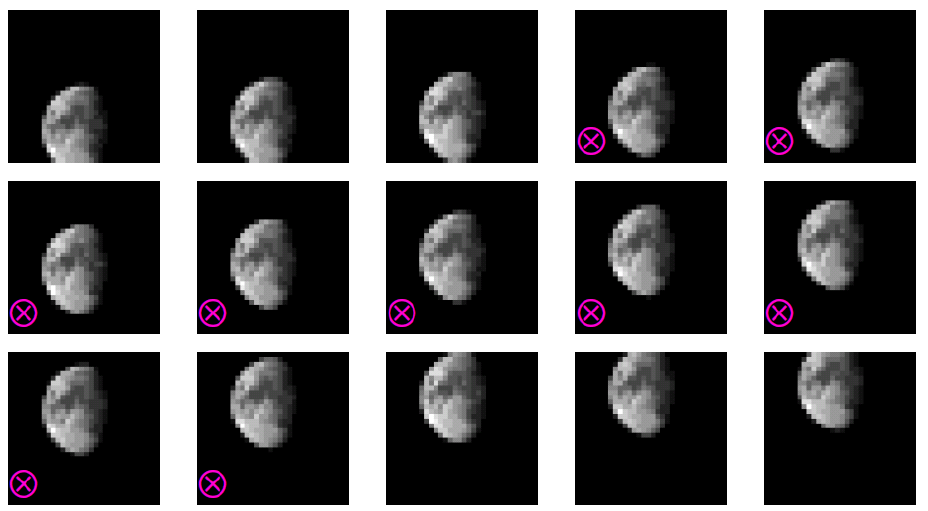
Figure 2. Scan-by-scan Band I1 images during the April 2015 lunar calibration: the horizontal direction is the along-scan direction; the vertical direction is the along-track direction. The symbols in the lower left corner mark those scans with complete lunar images (not being cut-off by the top or bottom edge of the FPA).